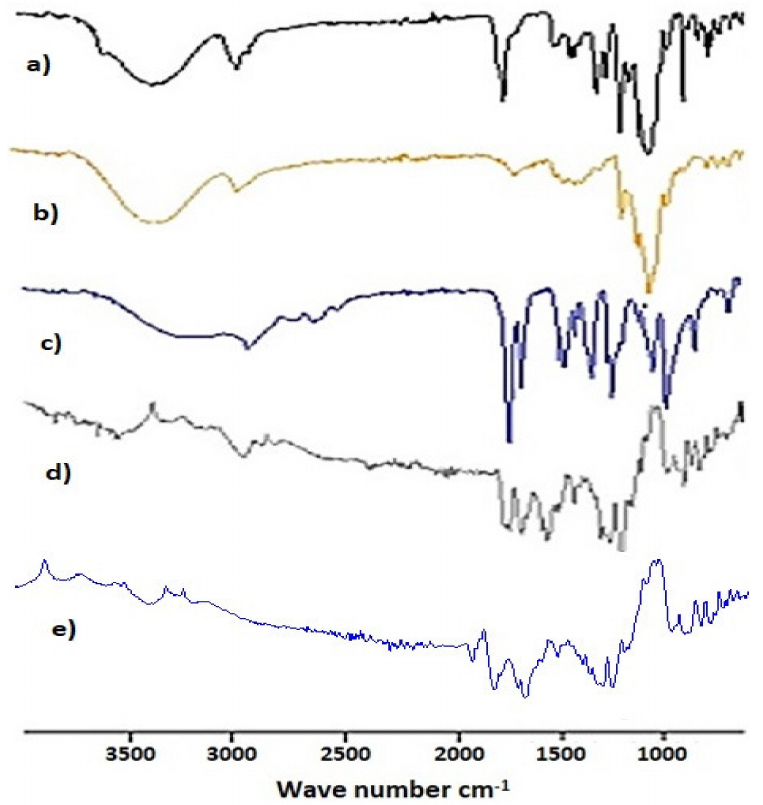
Figure 8. FTIR spectra of ( a ) pure drug (SIM), ( b ) polymer (chitosan), ( c ) monomer (MAA), ( d ) sim- vastatin loaded nanomatrices, and ( e ) un-loaded